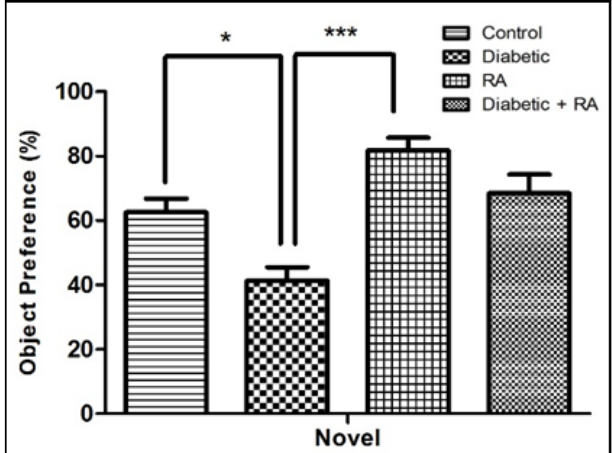
FIGURE 3 - Effects of Hyperglycemia on Memory and Cognition Using Novel Object Recognition (NOR) Test: The graph depicts the percent time spent exploring the novel object in NOR test. In comparison with the control, the diabetic groups showed a significant decline in novel object recognition which indicates compromised memory in the latter. Data was analyzed using one-way ANOVA, followed by multiple comparison Bonferroni test. The data is expressed as mean ± SEM, * p < 0.05 , *** p < 0.0005